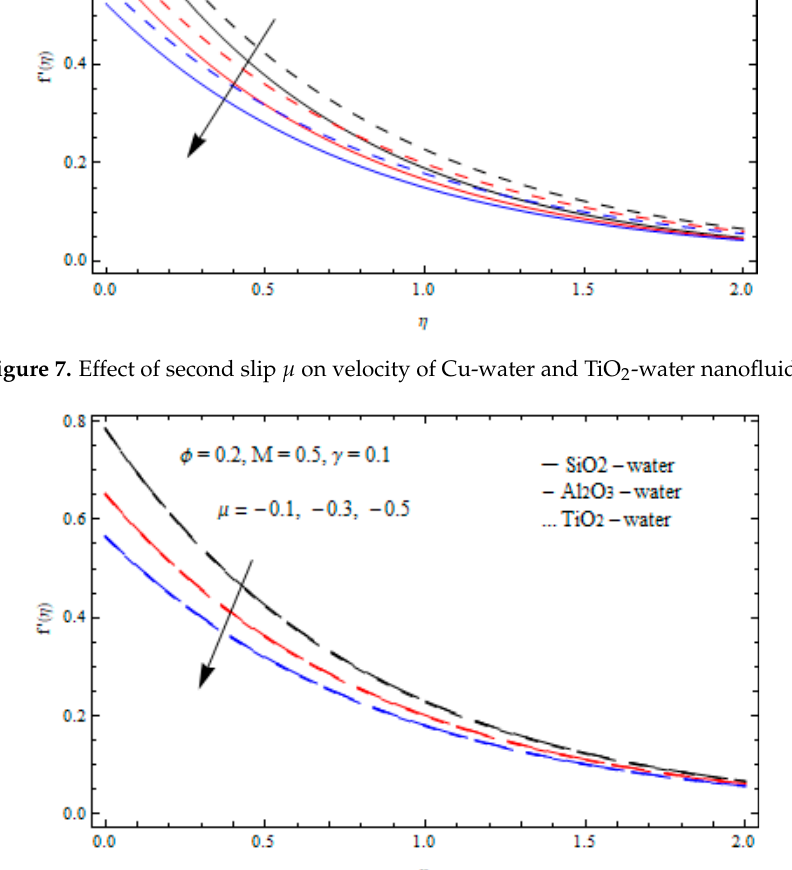
μ Figure 8. Effect of second slip on velocity of SiO 2 -water, Al 2 O 3 -water, and TiO 2 -water nanofluids. Figure 8. Effect of second slip µ on velocity of SiO 2 -water, Al 2 O 3 -water, and TiO 2 -water